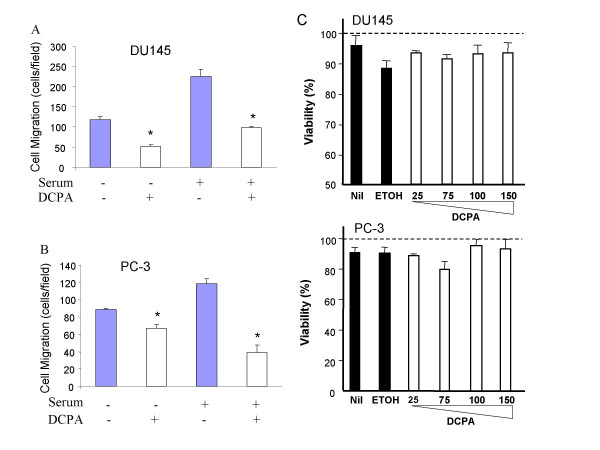
Migration of prostate cancer cells was inhibited by DCPA. Prostate cancer cells, DU145 (A) and PC-3 (B) cells, were cultured in serum-free medium in the presence (+) or absence (-) of 150 μM DCPA for 18 h as indicated. The cell migration assay was performed using Transwell migration chambers coated with 10 μg/ml collagen in the migration buffer with or without 10% fetal bovine serum for 6 h at 37°C as described in Materials and Methods. The migrated cells were counted, and data were expressed as mean of cell counts from replicate experiments. Bars, SD; * indicates significant difference when compared to cell migration without DCPA (P < 0.01). C. Viability of the prostate cancer cells was not affected by DCPA. The cells were cultured in the absence or presence of DCPA for 24 h, and cell viability assay was performed as described in Materials and Methods. The results were expressed as the mean percentage of cells capable of excluding trypan blue. These experiments were repeated at least twice. Bars, SD.